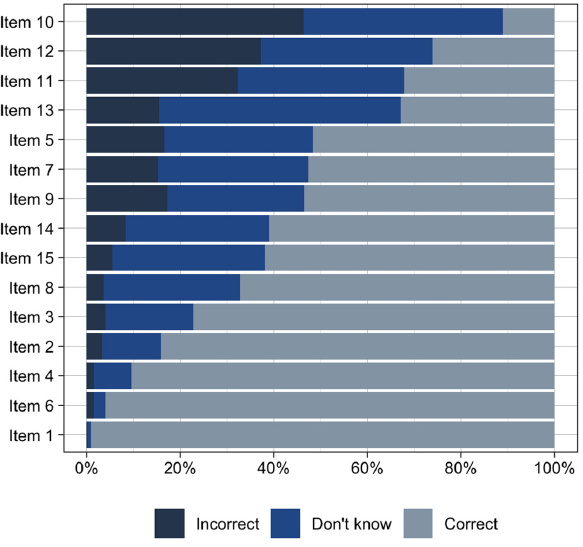
Figure 2. Item response distribution for 15-item MAPL.